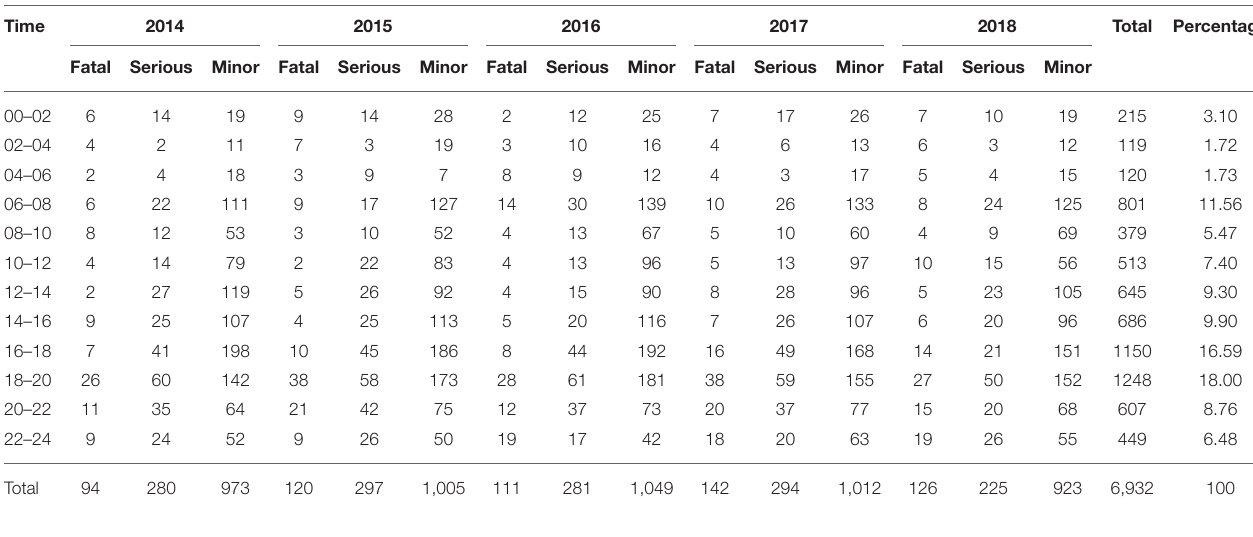
TABLE 5 | Casualty injury by time of the